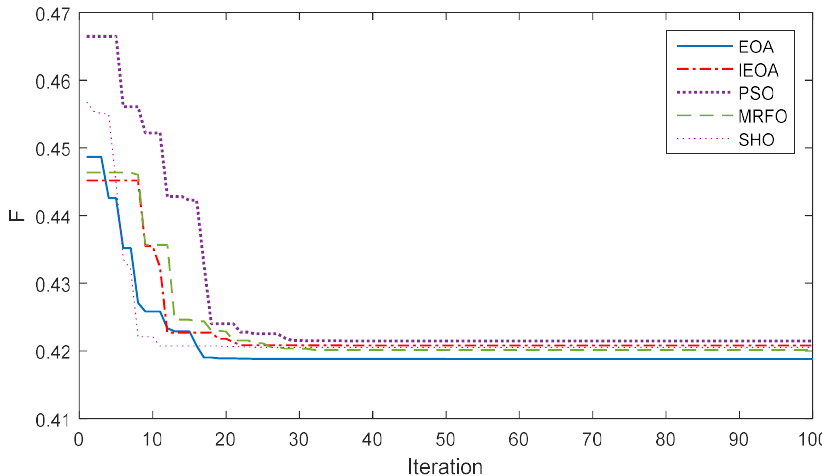
Figure 3. Convergence curves of different algorithms in DMM-based problem solving.